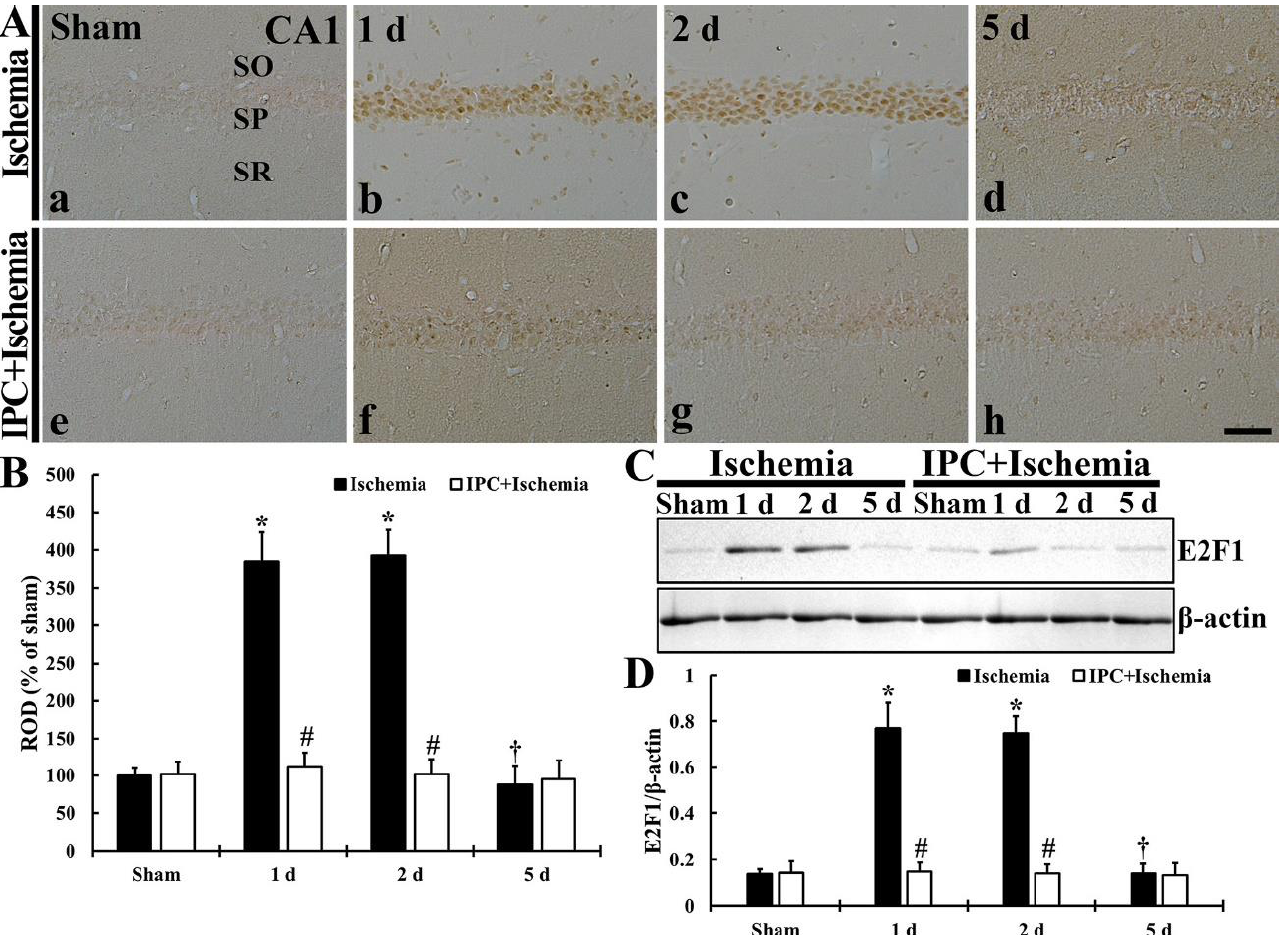
Figure 8. ( A ) Immunostaining of E2F1in CA1 of the TI (upper column) and IPC+TI (lower column) groups at sham (a,e), 1 day (b,f), 2 days (c,g), and 5 days (d,h) after TI. E2F1 immunoreactivity is dramatically increased in the pyramidal cells at 1 day and 2 days after TI, but, in the IPC+TI group, E2F1 immunoreactivity is similar to that shown in the sham group. Scale bar = 50 µ m. ( B ) Quantitative graph of E2F1 immunoreactivity in pyramidal cells. ROD was calibrated as percent (sham group, 100%). The bars represent means ± SD ( n = 7, * p < 0.05 versus sham; # p < 0.05 versus TI group; † p < 0.05 versus prior time point of each group). ( C ) Western blot of E2F1 (60 kDa) in CA1 of the TI and IPC+TI groups at sham, 1 day, 2 days and 5 days after TI. β -actin is used for a protein loading control. ( D ) Relative band intensity of E2F1 level. The bars represent means ± SD ( n = 7, * p < 0.05 versus sham; # p < 0.05 versus TI group; † p < 0.05 versus prior time point of each group).